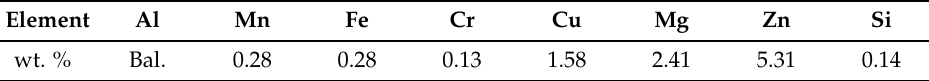
Table 1. Chemical composition of wrought 7075 Al alloy in wt.